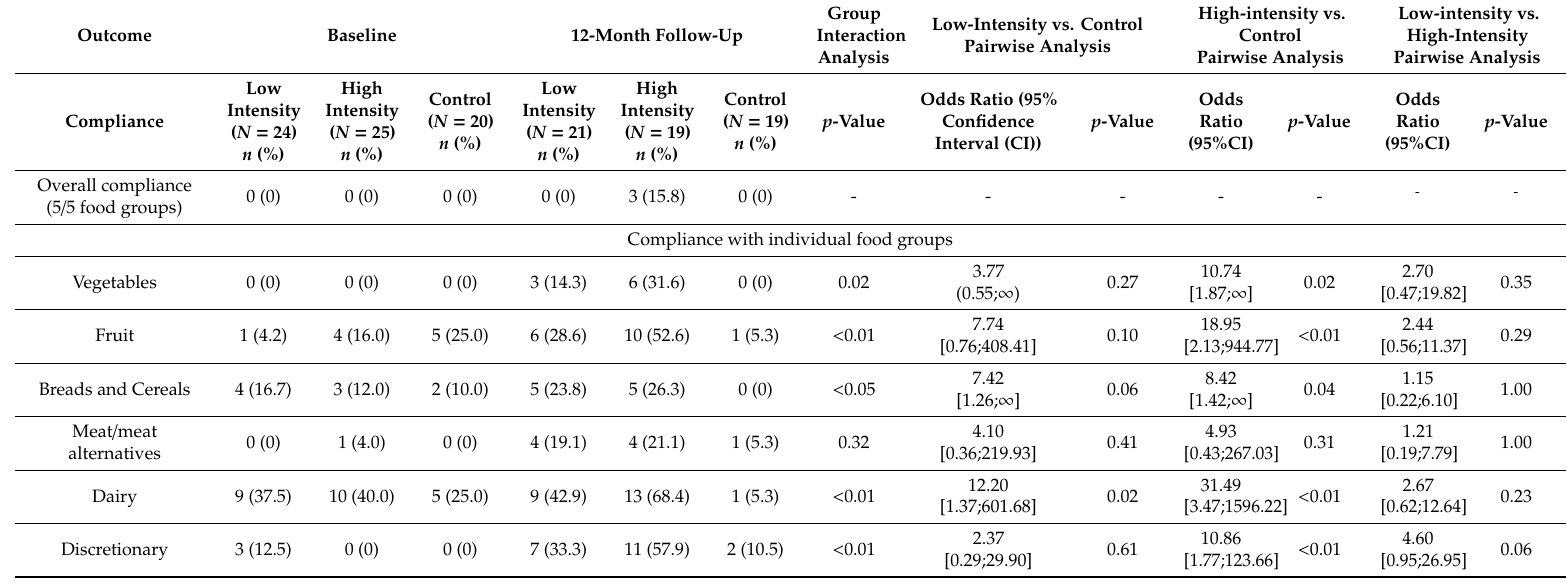
Table 3. Overall and individual Australian Guide to Healthy Eating (AGHE) food group menu compliance at baseline and 12-month follow-up a.